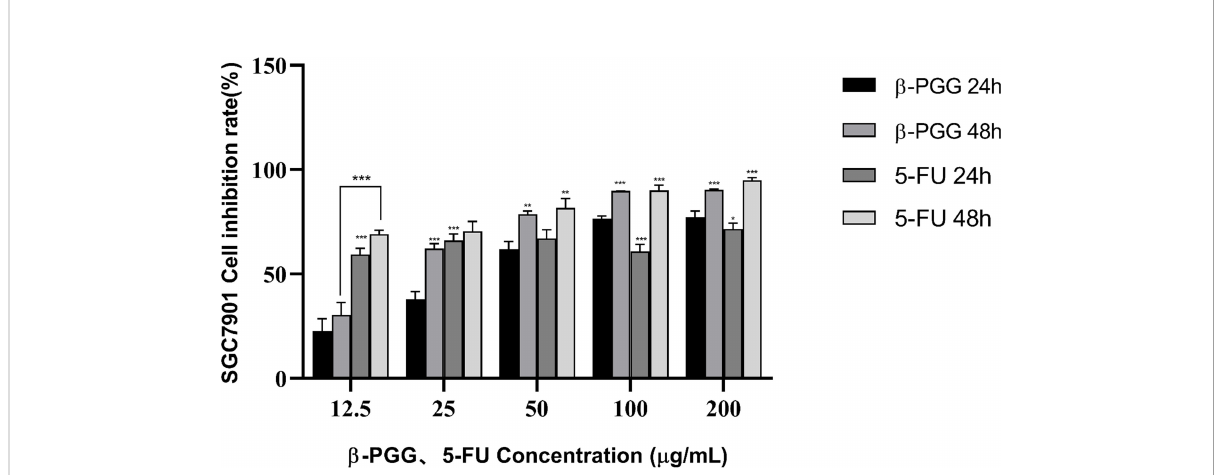
FIGURE 5 Effect of b -PGG on the proliferation of SGC7901 cells. SGC7901 cells were treated with different concentrations of b -PGG and different concentrations of 5-FU (12.5, 25, 50, 100, and 200 m g/ml) for 24 and 48 h and detected by the CCK-8 assay. * p < 0.05, ** p < 0.01, *** p < 0.001 vs. b -PGG 24